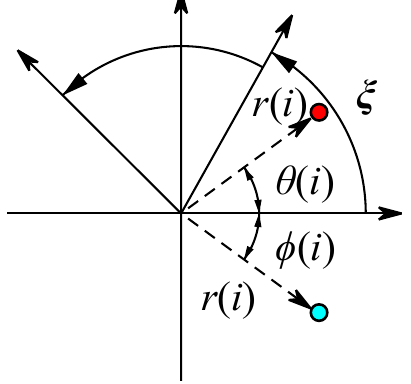
Figure 1. Principle of SDP.